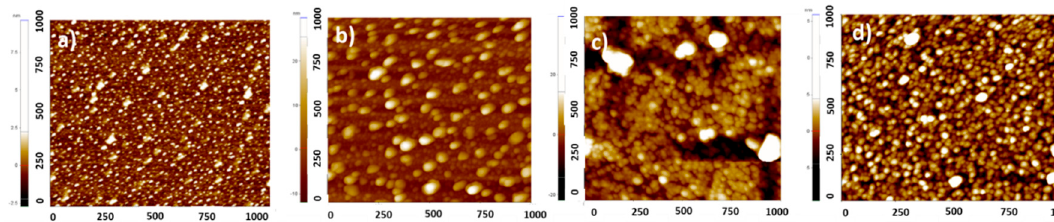
Figure 6. The atomic force microscopy (AFM) non-contact mode images of Ag 2 O deposited with: ( a ) 25 cycles ( R a 0.7 nm); ( b ) 100 cycles ( R a 1.5 nm); ( c ) 250 cycles ( R a 1.6 nm); and ( d ) 500 cycles ( R a 1.7 nm). Axis scales are in nm.